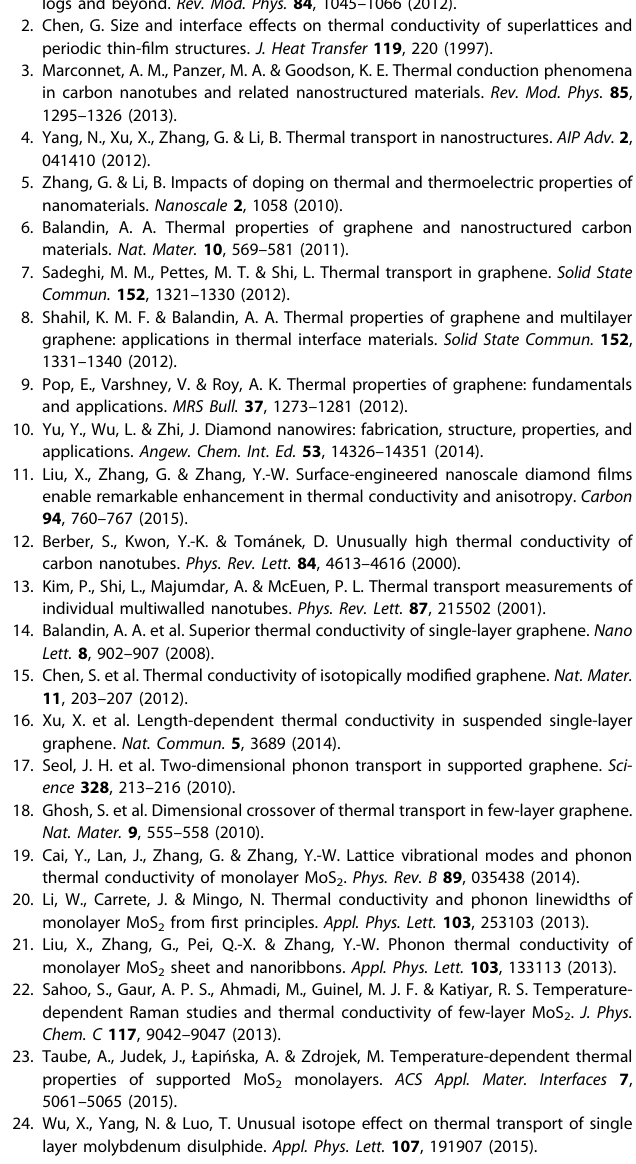
Per-area thermal conductance (nWK − 1 nm − 2